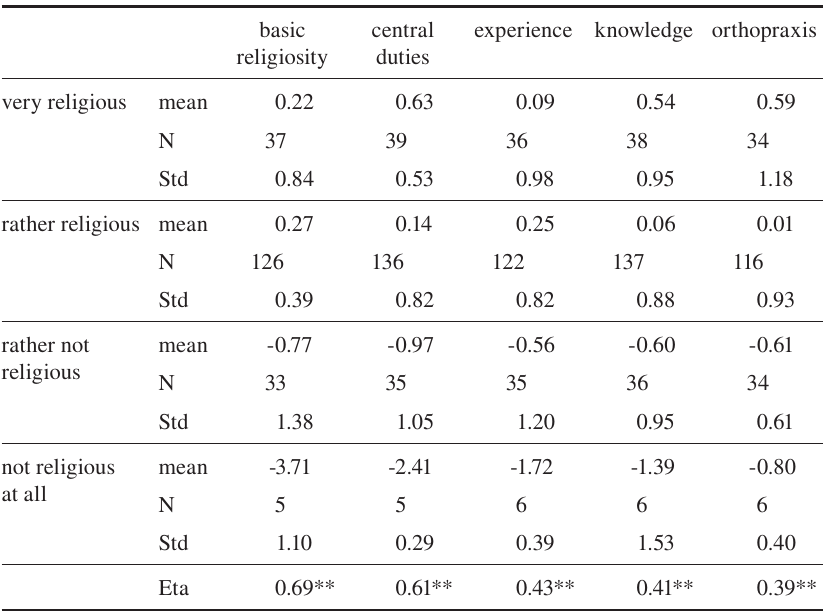
Table 7 : Mean differences between the five dimensions of religiosity in asso- ciation to the religious